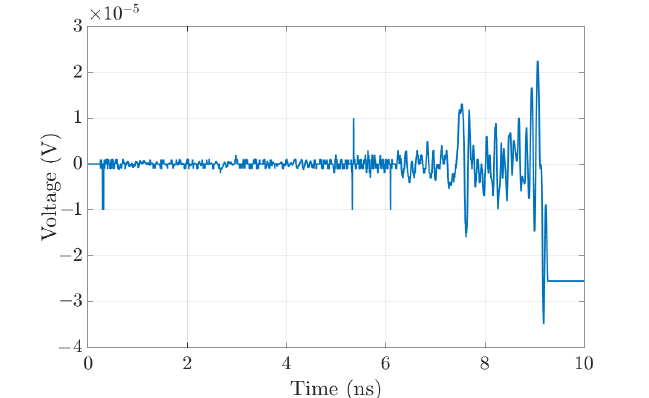
Figure 16. Measuring the reflected voltage generated by the far anti-dipole Vivaldi antenna from the simple large blade with one crack and two